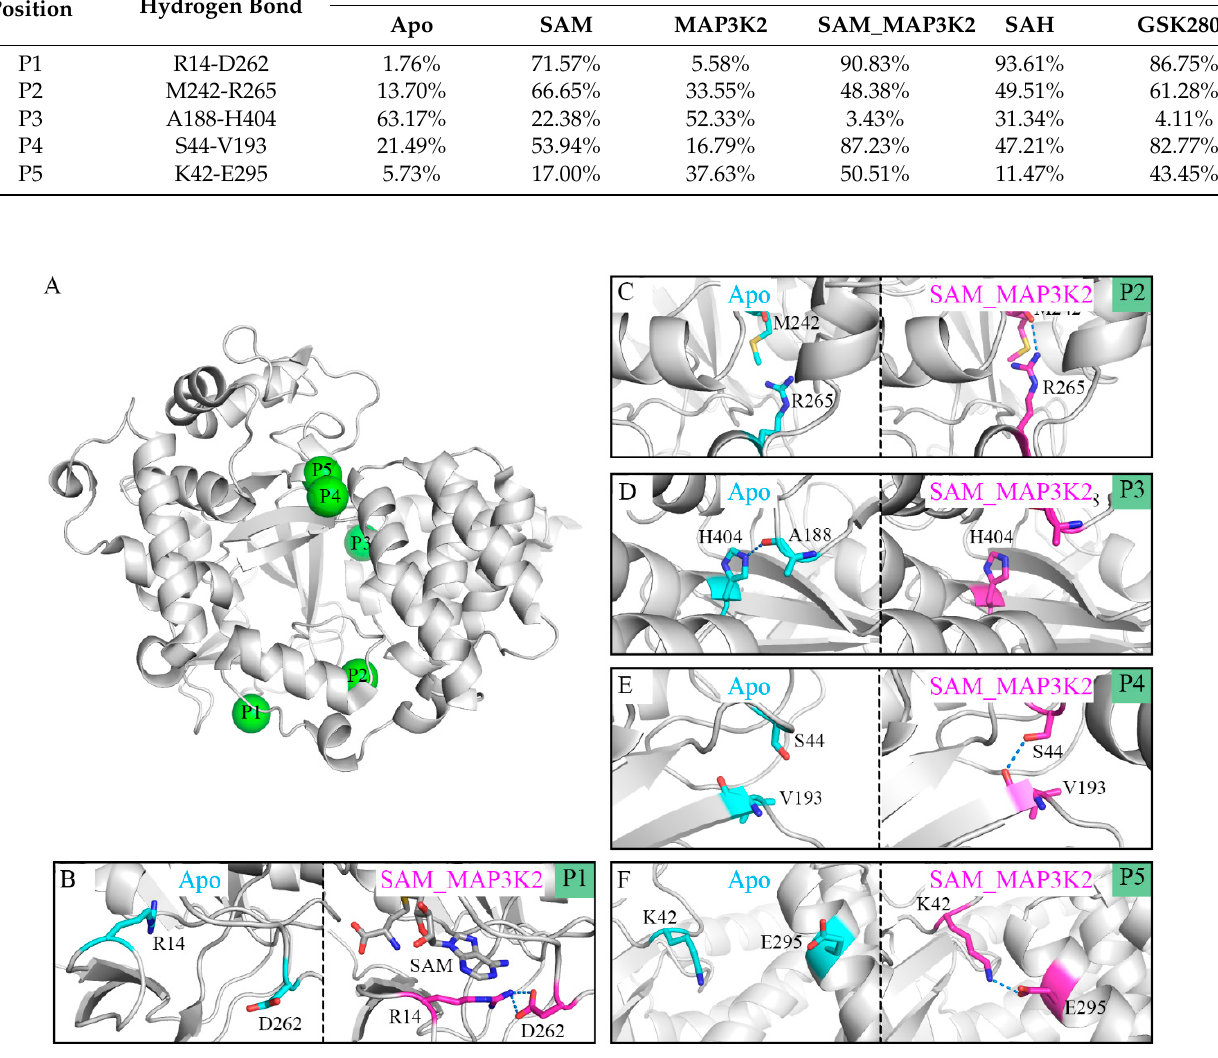
Figure 4. Distinct binding states of hydrogen bonds between the Apo and SAM_MAP3K2 systems. ( A ) P1–P5 positions labeled in the structure of SMYD3. ( B – F ) Binding states of hydrogen bonds at the P1–P5 positions in the Apo (cyan) and SAM_MAP3K2 (magenta) systems. Hydrogen bonds are depicted as dashed lines. Table 2. Occupancies of hydrogen bonds at the P1–P5 positions during MD simulations.